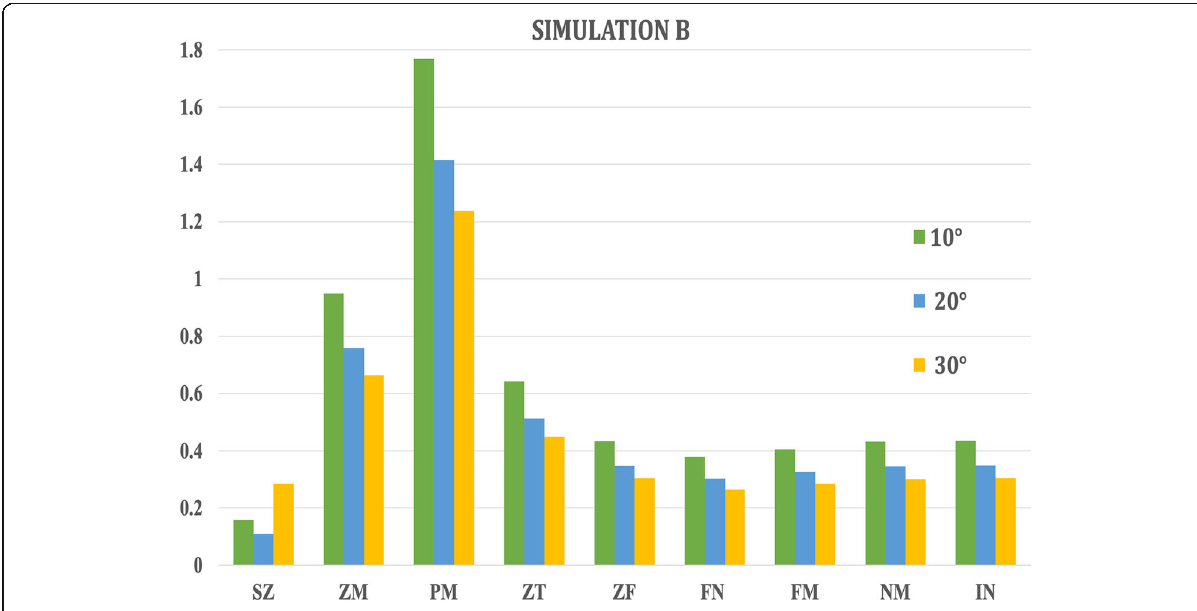
Fig. 5 Von Mises stresses generated in craniofacial sutures with different angulations (10° to 30°) in Simulation